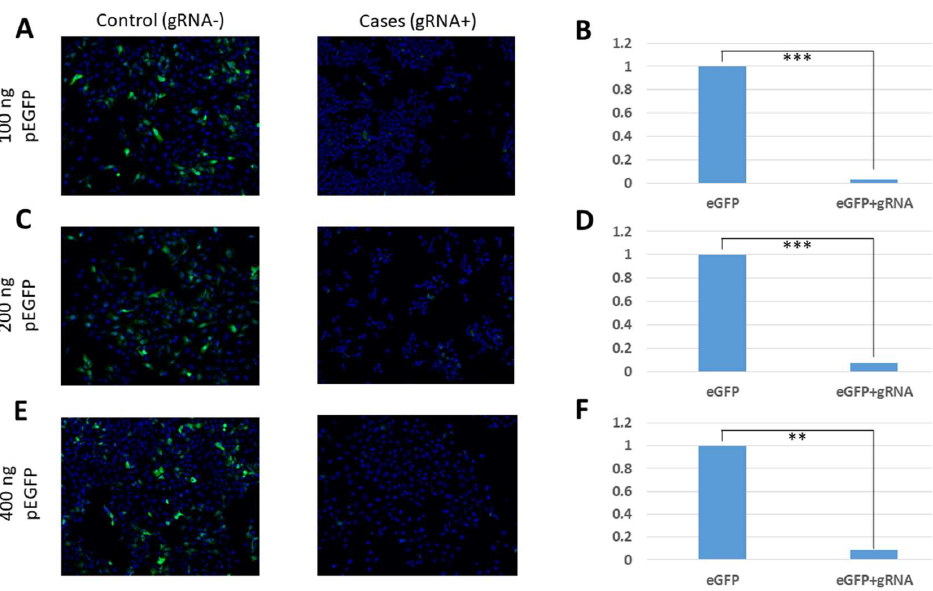
Figure 2. Representative fluorescence microscopy images of the cultures with gRNA (case situations) and without gRNA (control situations) (10X). From top to bottom—each row represents the different concentrations of the transfected plasmid pEGFP-C1: ( A ) 100 ng; ( C ) 200 ng; and ( E ) 400 ng. From left to right—each column represents the different situations for each condition. The first column represents the control situation without gRNA transfection and the second column represents the cell line transfected with gRNA. Each image represents a combination of two images taken at an excitation of 489 nm to allow the visualisation of eGFP fluorescence, and at 350 nm to allow the visualisation of the Hoechst dye. Exposures of 100 ms for green fluorescence and 10 ms for blue fluorescence were used. The statistical analyses of the normalised mean eGFP fluorescence in control and case situations for each pEGFP-C1 concentration: ( B ) 100 ng; ( D ) 200 ng; and ( F ) 400 ng. A two-sided t test with unequal variance and significance was used, indicated as: * p ≤ 0.05; ** p ≤ 0.01, and *** p ≤ 0.001